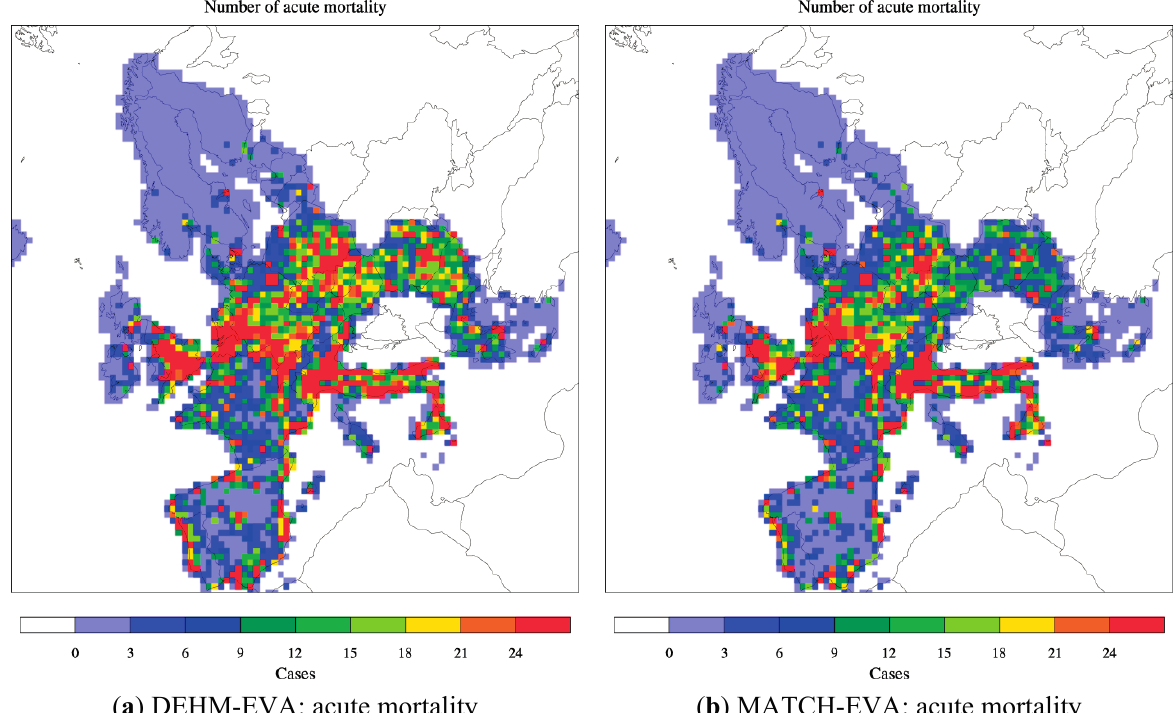
Figure 2. The spatial distribution of acute mortality across Europe related to O 3 (SOMO35). Based on DEHM ( a ) and MATCH ( b ) simulations with climate, emissions and population data for 2000 (the base “present day” case). The area of a grid cell is 50 km × 50 km = 2500 km 2 . The colour bar refers to number of cases per year per 2500 km 2 . See Figures 4 and 6 for the total number for Europe and the Nordic